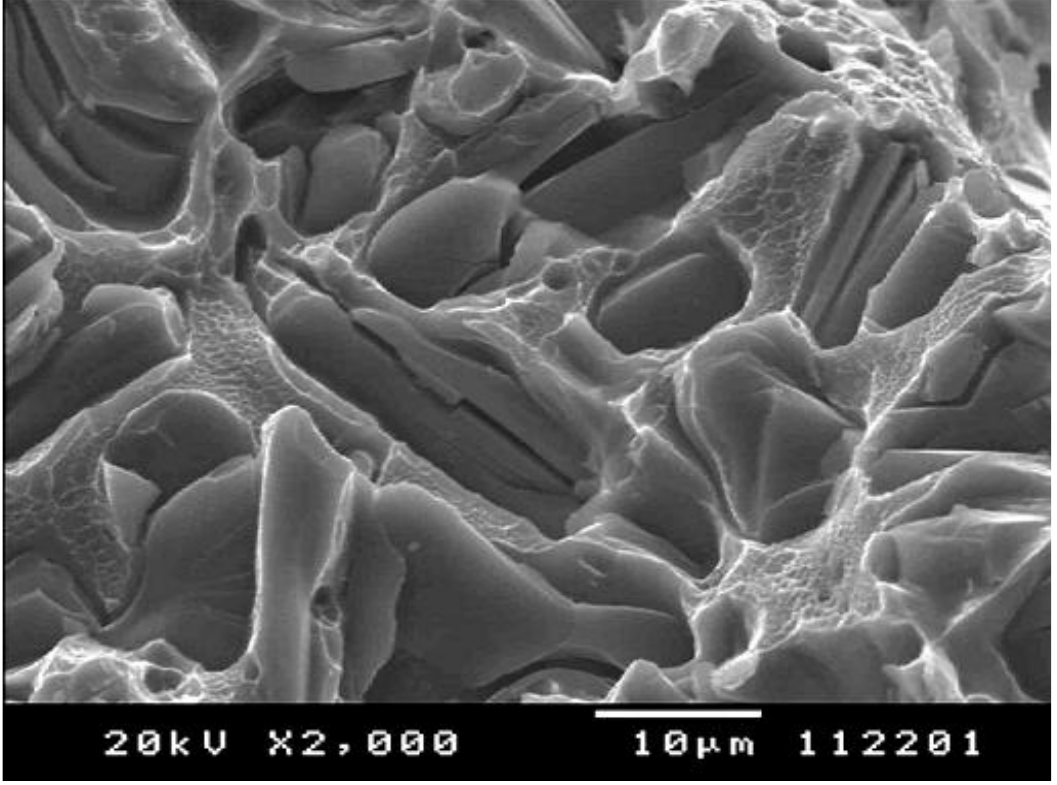
Figure 6. SEM image of a fracture surface of an Al-Si eutectic phase (Courtesy M.